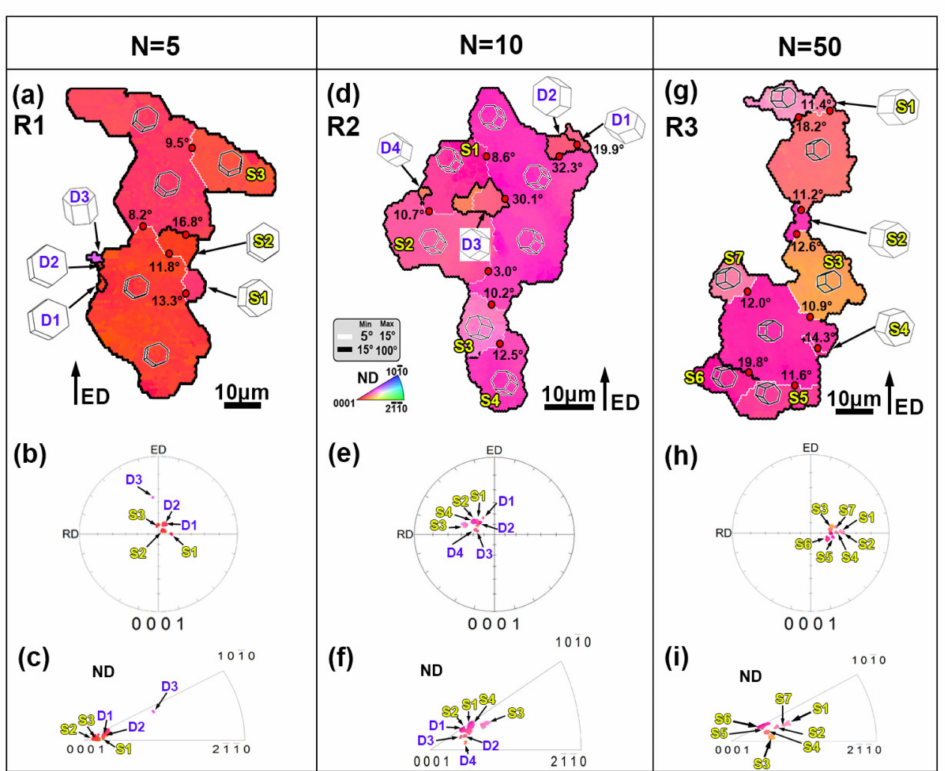
Figure 7. The DRX mechanism of the RBE samples in the unDRX zones ( a – c ) R1, ( d – f ) R2, and ( g – i ) R3 selected in Figure 5g–i: ( a , d , g ) inverse pole figure (IPF) maps, the corresponding orientation highlighted in ( b , e , h ) (0001) pole figure (PF), and ( c , f , i ) inverse pole figure (IPF). S-subgrain; D-DRXed